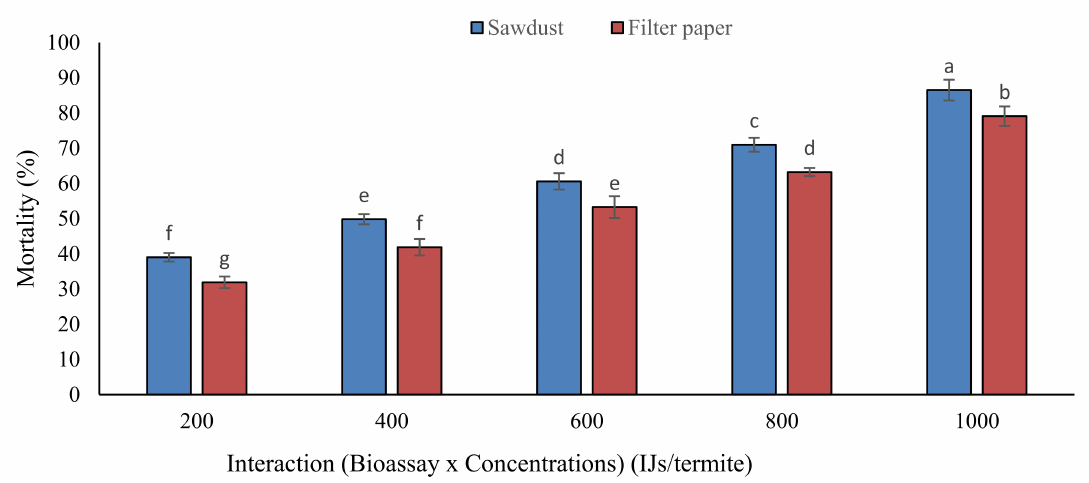
Figure 4. Interactive effect of bioassays × nematode concentrations (B × C) on percentage mortality of Odontotermes obesus workers kept under laboratory conditions (26 ± 1 ◦ C). Bars with different lowercase letters were significantly different at p ≤ 0.05 (LSD test). Vertical bars indicate standard error (SE) values.